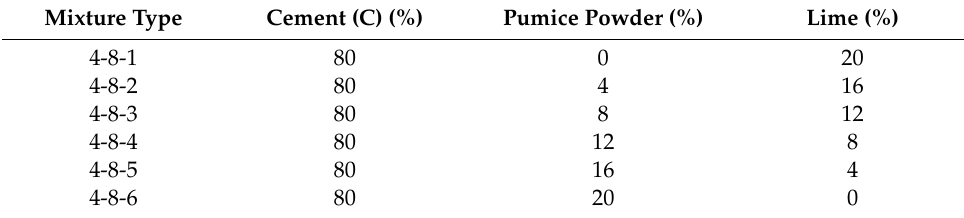
Table 14. Type 4-8 mixing ratios.